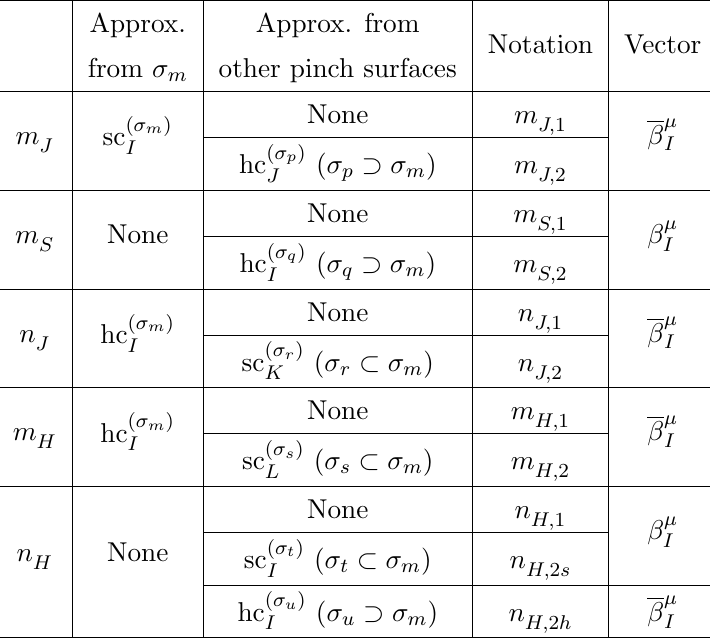
Table 7. The notations we use to mark the propagators with di(cid:11)erent approximations. In the last column, we denote the produced vectors that form products with (cid:13)